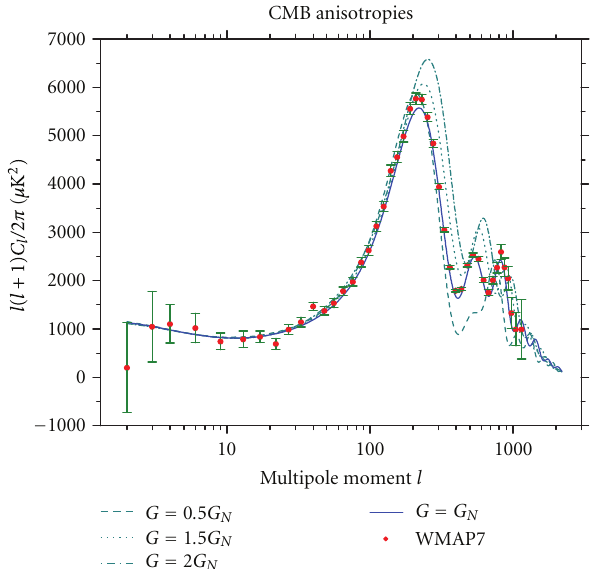
Figure 1: Cosmic microwave background anisotropies. With small dash symbol are the WMAP 7 years experimental observations [53]. We have plotted several cases in which the Newton constant has been modified. The standard case is shown with a small dash line. With a long dash line is shown an e ff ective gravitational constant, G e ff = 0 . 5 G N . With a dotted line is shown the case with G e ff = 1 . 5 G N , and with a dash-dotted line is shown the case with G e ff = 2 G N